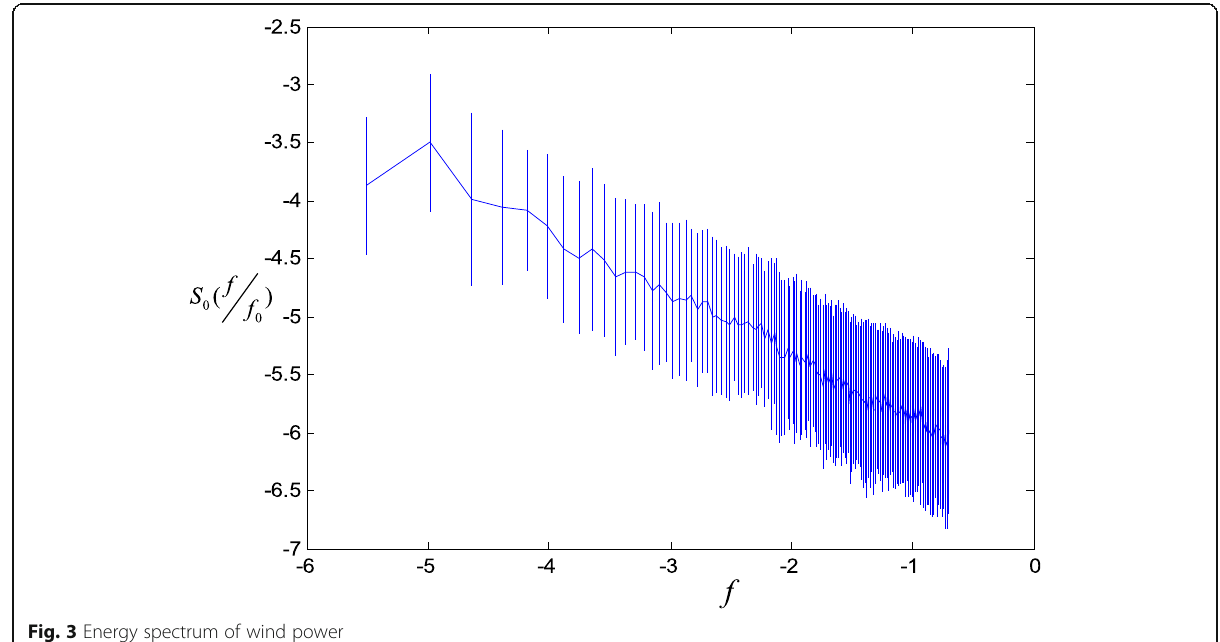
Fig. 3 Energy spectrum of wind power